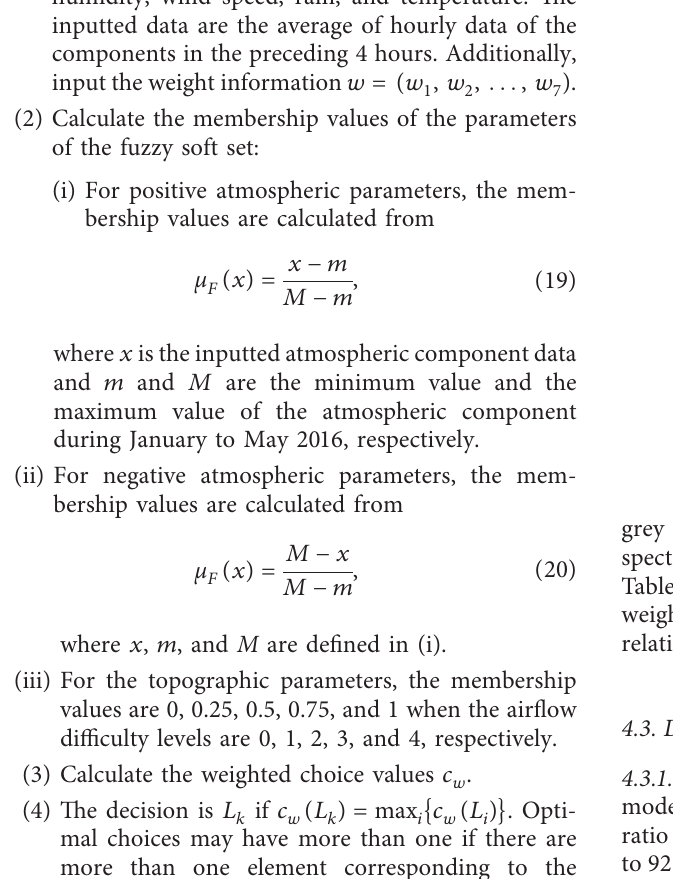
Table 13. Cohen’s kappa of the decision making based on weighted choice values, weighted score values, and grey relational grades is 0.4457, 0.4521, and 0.4489, respectively.